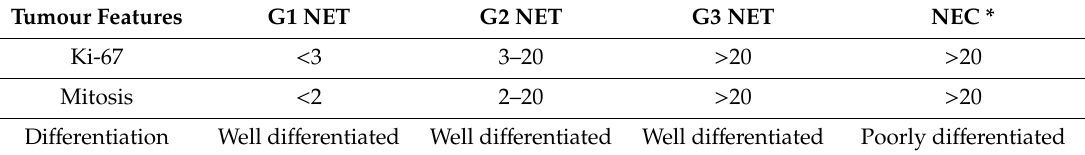
Table 1. WHO Classification Pancreatic neuroendocrine tumours (PanNET), 2017. Tumour Features G1 NET G2 NET G3 NET NEC * Ki-67 < 3 3–20 > 20 > 20 Mitosis < 2 2–20 > 20 > 20 Di ff erentiation Well di ff erentiated Well di ff erentiated Well di ff erentiated Poorly di ff erentiated * Large cell and small cell neuroendocrine carcinoma should be considered as separate subtypes. Legend: PanNETs—pancreatic neuroendocrine